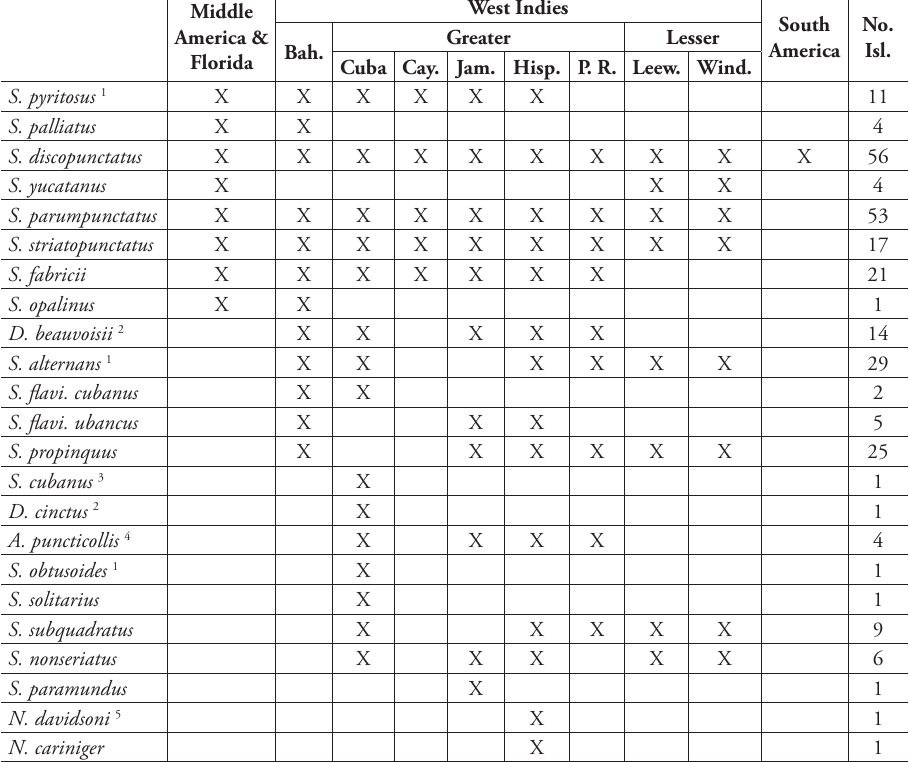
Table 9. Distribution of the species and subspecies of Selenophori group in the West Indies.